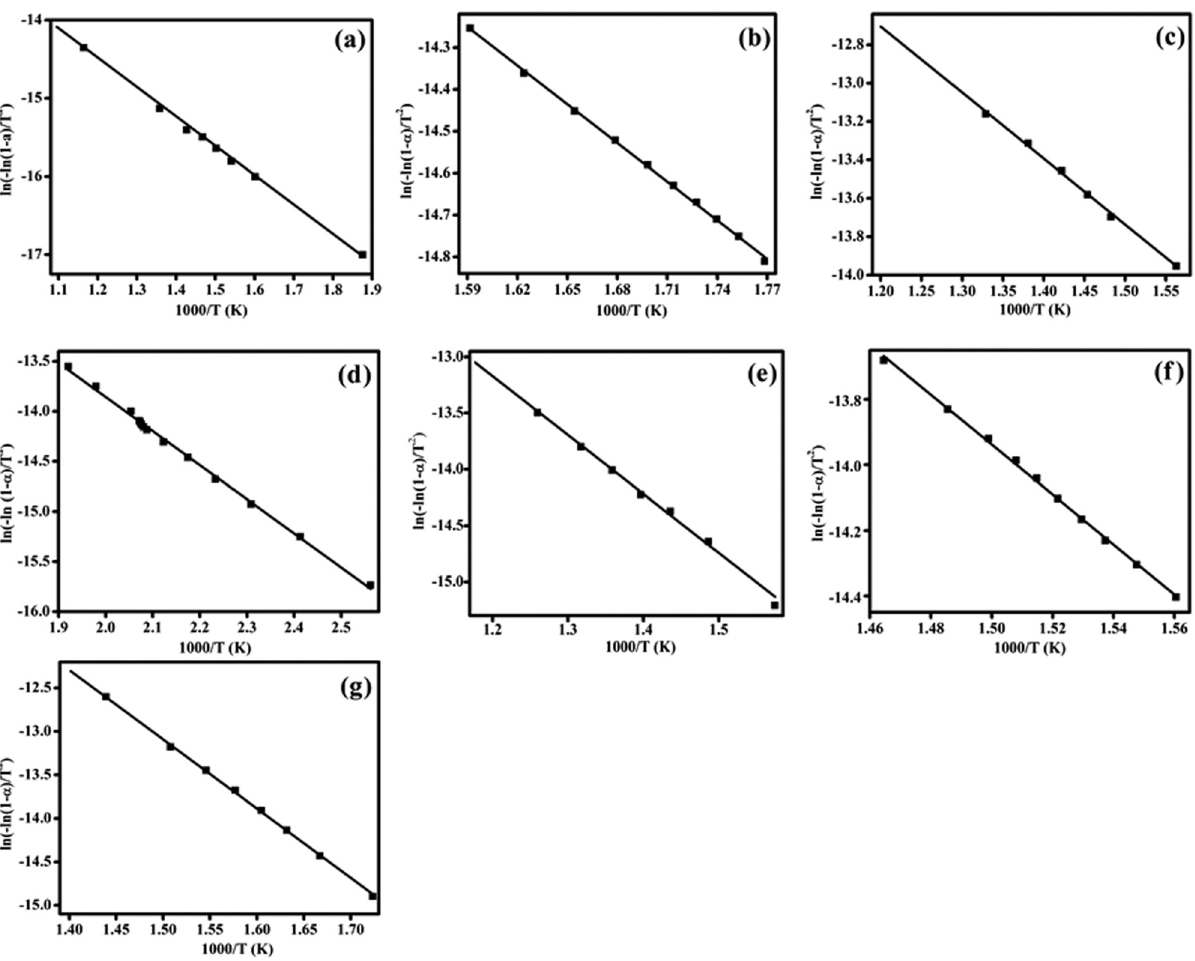
Figure 3: Coats – Redfern plots for major decomposition of ( a ) L, ( b ) [ CoL ( ac ) 2 , II step ] , ( c ) [ CoL ( ac ) 2 , III step ] , ( d ) [ NiL ( ac ) 2 ] , ( e ) [ CuL ( ac ) 2 ] , ( f ) [ CuL ( acac ) ] , and ( g ) [ CuL ( fms ) ] 2 2